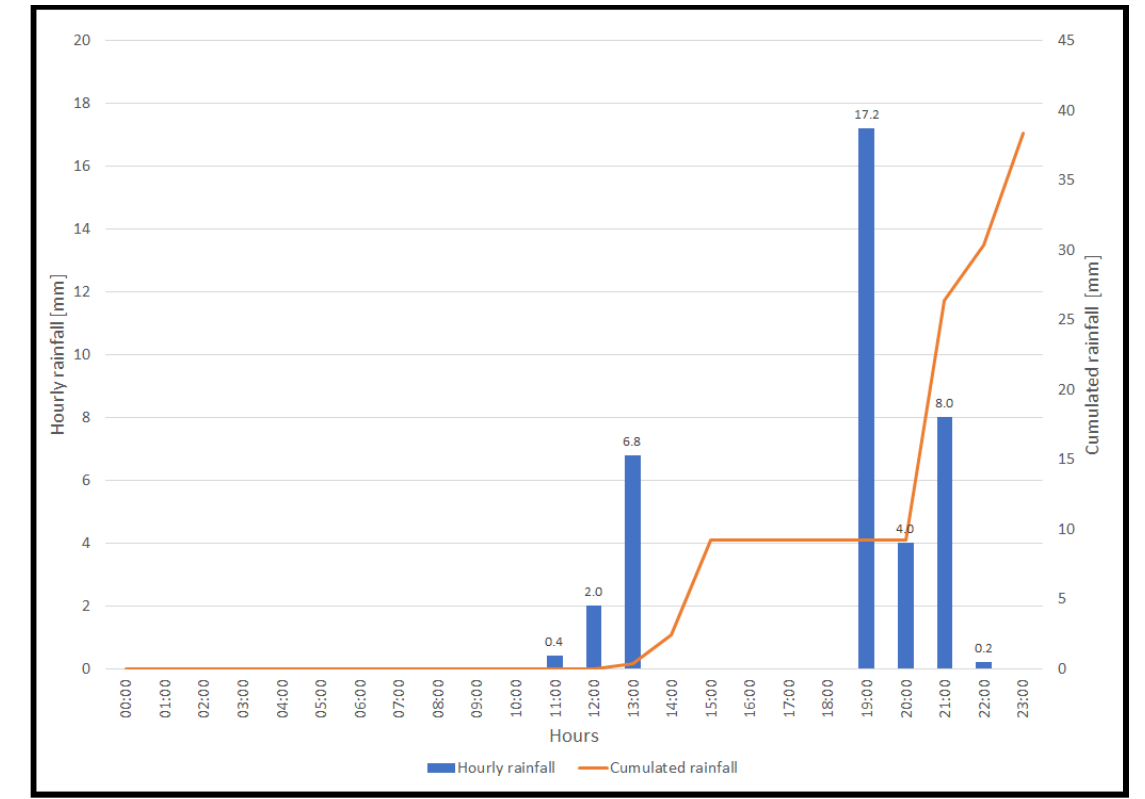
Figure 15. Hourly and cumulated rainfall recorded by Fomarco raingauge on 18 July 2005.